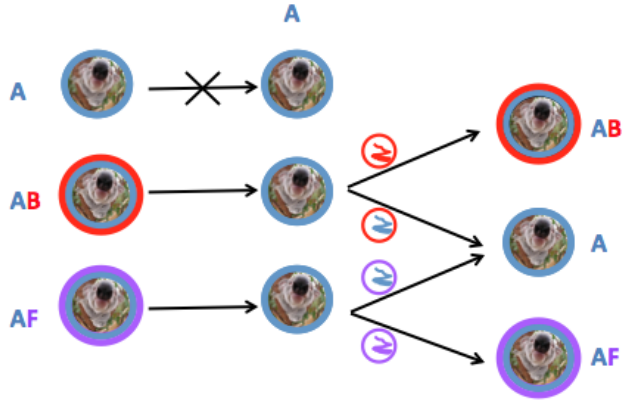
Figure 6. Mechanism of KoRV enveloped retroviral transmission in koalas infected with KoRV-A (represented as koalas within blue circles), KoRV-B (red encircled koalas) and/or KoRV-F (koalas within purple circles). The small circles represent KoRV viral particles composed of KoRV-A, B, or F envelopes (blue, red or purple, respectively) and the folded lines within the circles represent the KoRV-A, KoRV-B or KoRV-F genomes (red, blue or purple lines, respectively). KoRV-A positive animals are resistant to superinfection by KoRV-A (top most figure) but the KoRV-A genome (blue) can be transmitted in particles bearing KoRV-B (red) or KoRV-F (purple)